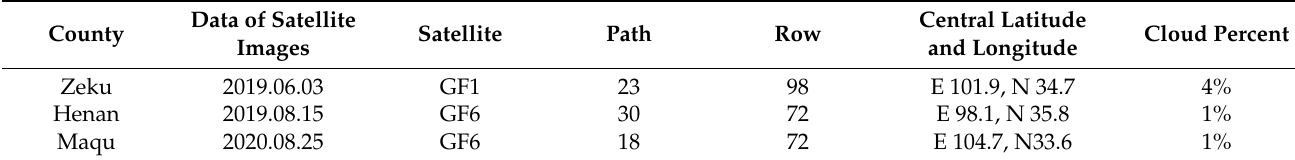
Table 3. List of GF1/6 WFV images used in this